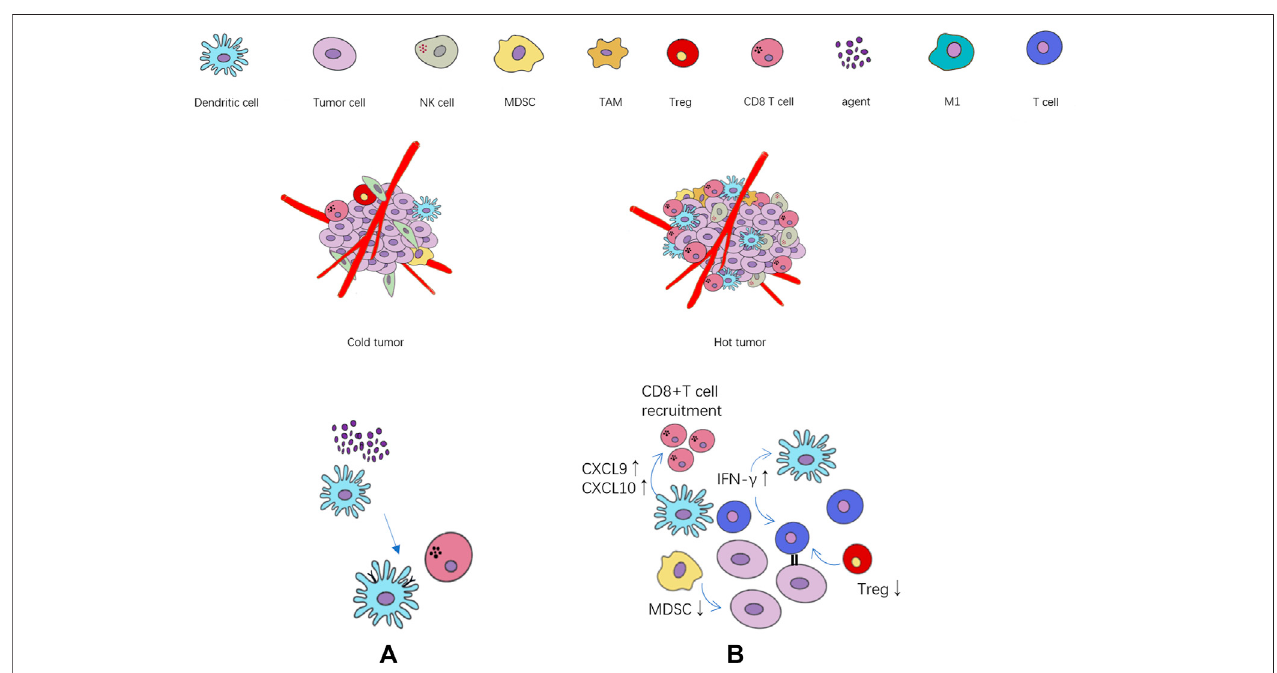
FIGURE 1 | The relationship between the state of tumor immune cell in fi ltration and immunotherapy. (A) The agents activate the maturation of dendritic cells, and further activate CD8+ T cell. (B) Cytokines, chemokines and immune cells associated with immune activation and immunosuppression state. ↑ : immune activation ↓ : immune